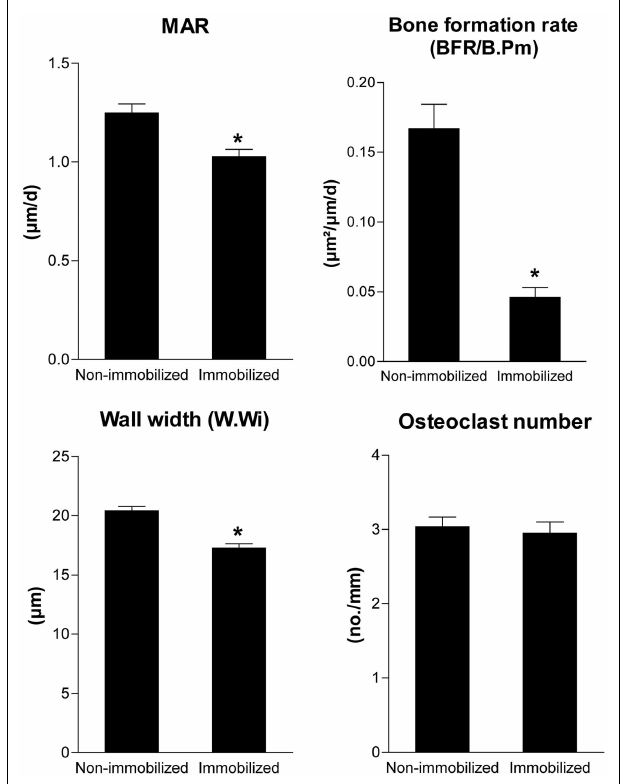
FIGURE 2 | Unloading reduces bone formation and wall width in the presence of unchanged osteoclast numbers . Mineral apposition rate, bone formation rate (BFR/B.Pm), wall width of completed remodeling units, and osteoclast numbers measured by histomorphometry in the cancellous bone of the proximal tibial metaphysis in 4-month-old non-immobilized control rats and immobilized female Sprague-Dawley rats after 4weeks of partial unloading by a bandaging technique (Erben et al., unpublished data). Data represent mean (cid:6) SEM of 12 animals each. * p < 0.05 by t